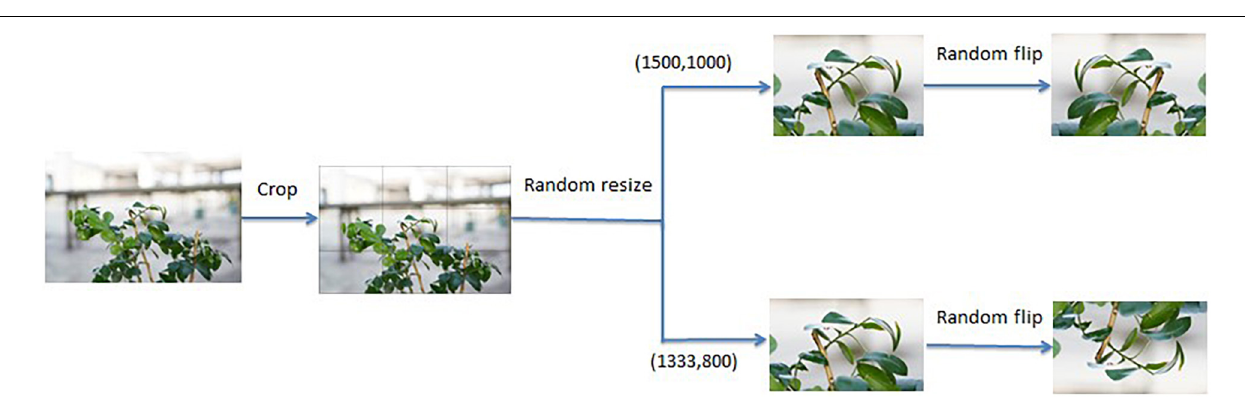
FIGURE 4 | Small sample number enhancement example diagram.